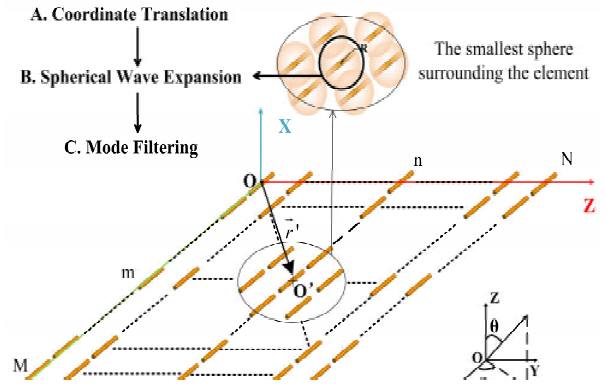
Figure 1. Schematic diagram of the mode filtering geometry of a planar array antenna.